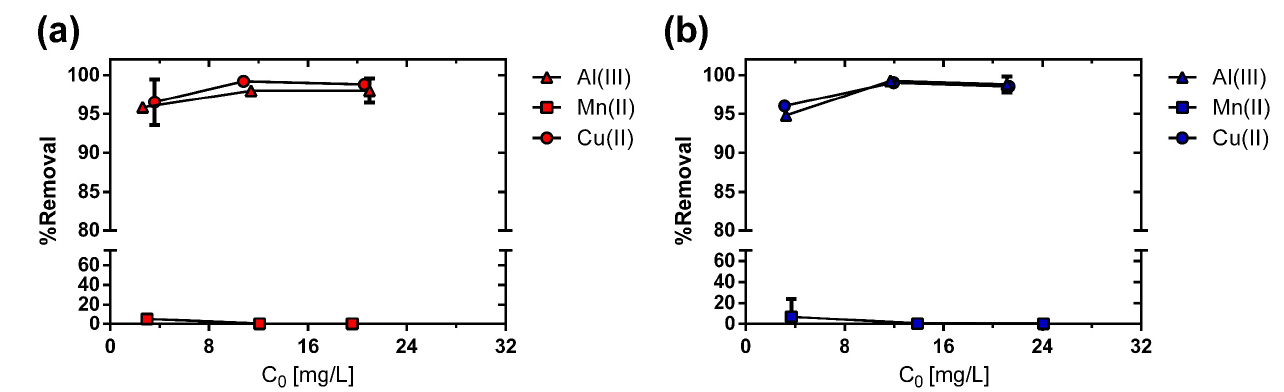
Figure 6. Removal percentages for Cu(II), Mn(II) and Al(III) under ( a ) pH1 (pH = 4.8) and ( b ) pH2 (pH = 4.0) at different initial concentrations.